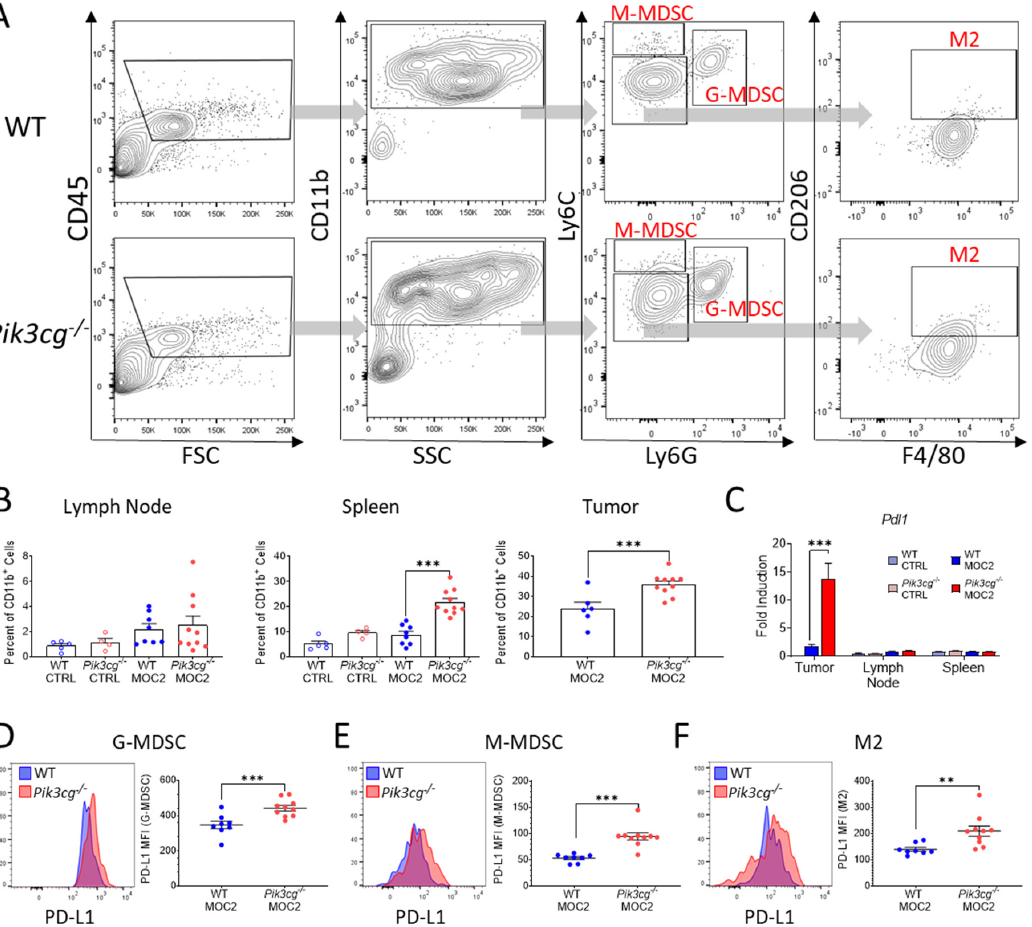
Figure 5. PI3K γ inhibition promotes tumor-associated myeloid populations, which express the immunosuppressive marker PD-L1 in the HNSCC tumor microenvironment. ( A ) Flow cytometry gating strategy for Ly6C + Ly6G + granulocytic myeloid-derived suppressor cells (G-MDSCs), Ly6C hi Ly6G - monocytic MDSCs (M-MDSCs), and F4/80 + CD206 + Ly6G - alternatively-activated macrophages (M2s) of experimental mice. ( B ) Population frequencies of G-MDSCs among CD11b + populations in the lymph nodes, spleens, and tumors of experimental mice. ( C ) Expression of Pdl1 within the sentinel lymph nodes, spleens, and tumors of experimental mice determined by RT-qPCR; ( D – F ) Mean fluorescent intensity of PD-L1 expression by ( D ) G-MDSC, ( E ) M-MDSC, ( F ) M2 populations in experimental mice accompanied by representative histograms demonstrating disparities in PD-L1 expression between WT and Pik3cg − / − mice.; ** p -value < 0.01; *** p -value < 0.005 between groups, as determined by Student’s t- test.